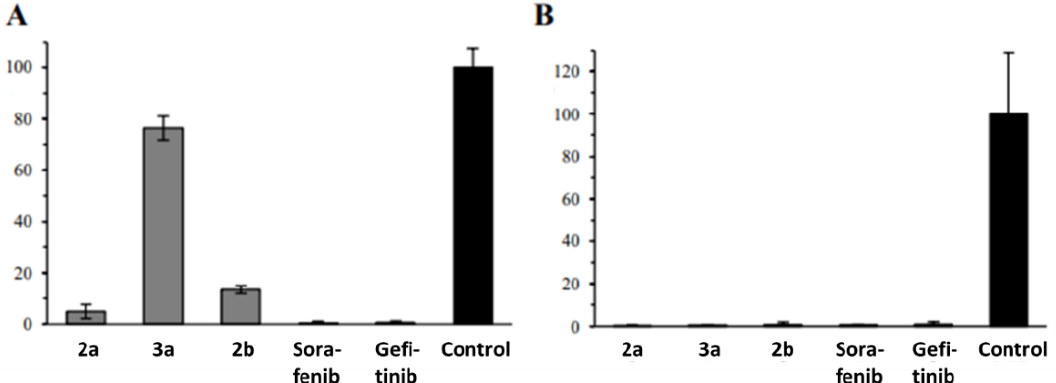
Figure 7. Inhibition of colony formation by 2a , 2b and 3a at their IC 50 doses in HCT-116 wildtype ( A ); and HCT-116 p53-knockout cells ( B ). Sorafenib (IC 50 ) and gefitinib (20 μ M for wildtype, IC 50 for p53-knockout cells) were used as positive controls. y-axis: Percentage of colonies compared to control, which was set to 100%. n = 3 ± SD.